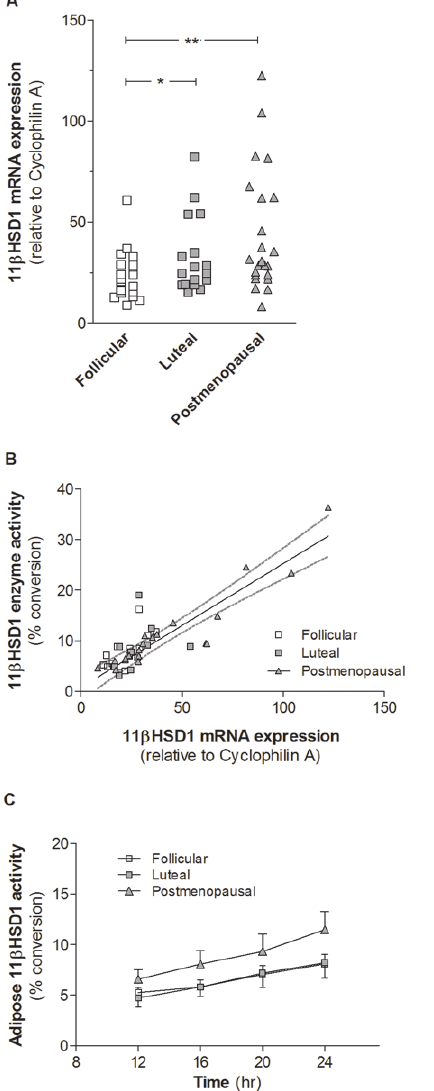
Figure 1. Subcutaneous adipose tissue 11 b HSD1. A 11 b HSD1 transcript levels were normalized to endogenous control Cyclophilin A. * P , 0.05, ** P , 0.01, N=19, 17, and 23 for the premenopausal follicular ( % ), luteal ( & ), and postmenopausal ( m ) groups, respectively. One woman in follicular phase and three in the luteal phase of the menstrual cycle did not have the biopsy and three women in each premenopausal group were found not to be in the correct phase. Data were natural log- transformed to achieve normal distribution. B Correlation between adipose 11 b HSD1 activity after 24 hr incubation (percent conversion) and adipose 11 b HSD1 mRNA expression (relative to Cyclophilin A). Premen- opausal follicular ( % ), luteal ( & ), and postmenopausal women ( m ). Linear regression line is shown for the postmenopausal group, dotted lines denotes the 95% confidence interval. C Subcutaneous adipose tissue 11 b HSD1 activity was measured as percent conversion of cortisol to cortisone over time in tissue homogenates, protein concentration 3 mg/ ml. N=13, 10, and 20 for premenopausal follicular ( % ), luteal ( & ), and postmenopausal women ( m ), respectively. There were no significant differences between the groups. Data were ln-transformed to achieve normal distribution and are shown as means 6 SEM.